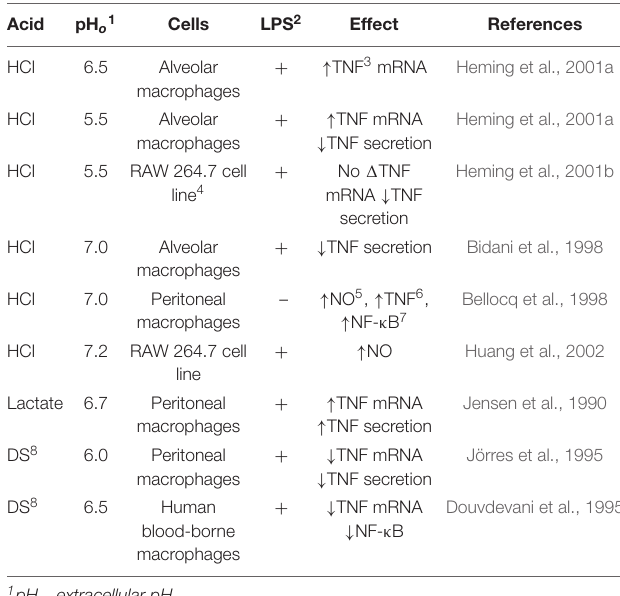
TABLE 2 | The effects of pH on inflammatory mediators in macrophages (Kellum et al.,